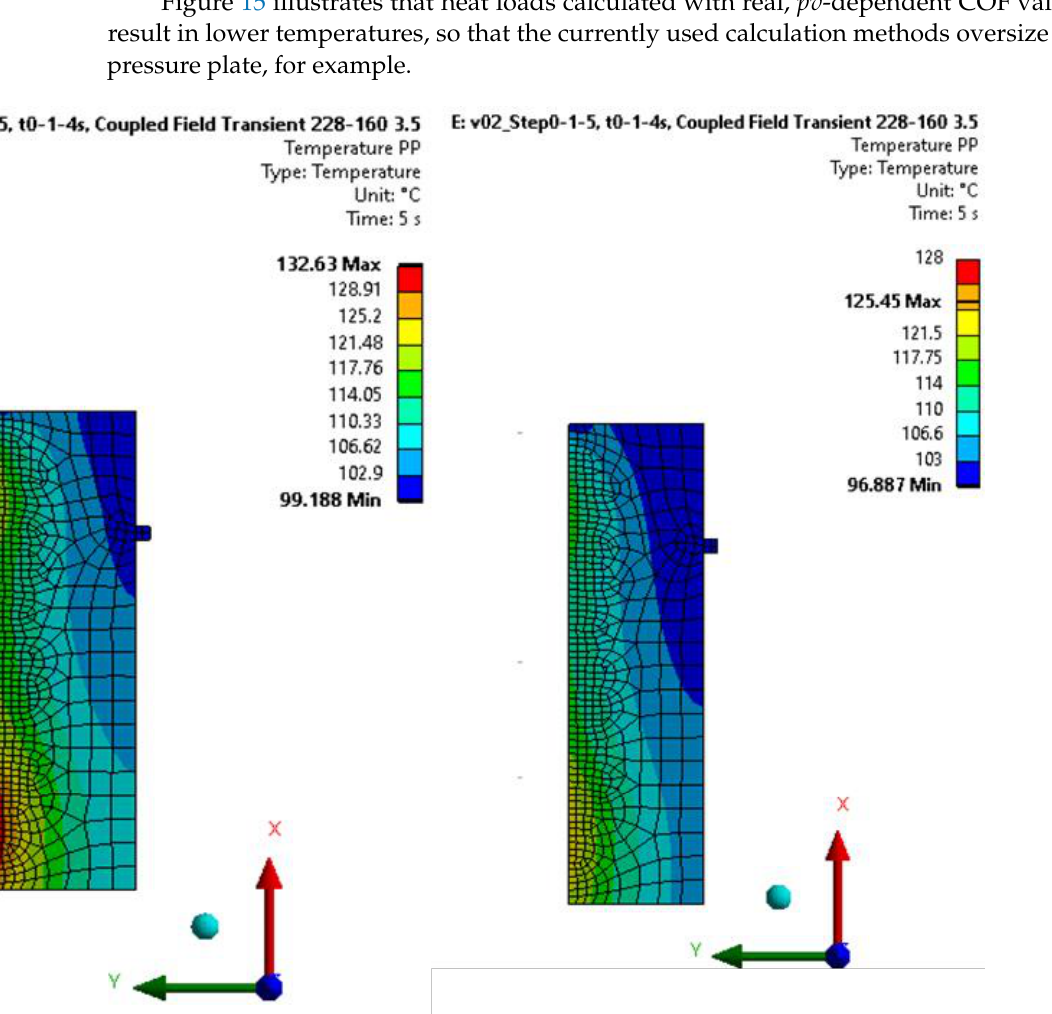
Figure 15. Temperature distribution on the trace plate: ( left ): constant COF, ( right ): pv-dependent COF.